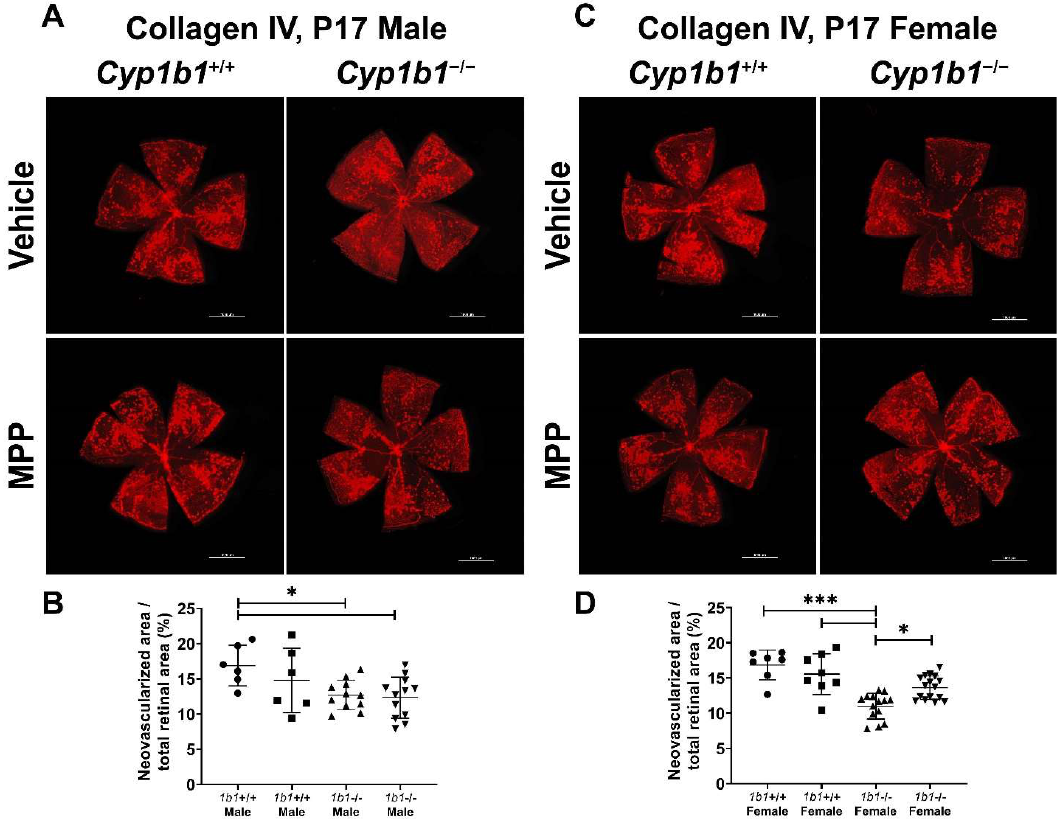
Figure 8. Restoration of retinal neovascularization in female Cyp1b1 − / − mice by ER α antagonist MPP during OIR. Retinas from P17 ( A ) Cyp1b1 +/+ mice and ( C ) Cyp1b1 − / − mice that were administrated with MPP (1 mg/kg; P12-P17) during OIR were wholemount stained with anti-collagen IV antibody and imaged by fluorescent microscopy. Scale bars = 1000 µm. Quantitative assessment of the neovascularization was performed using ImageJ and percentages of the neovascularized area relative to whole retina, shown in ( B , D ), respectively (* p < 0.05, *** p < 0.001; n ≥ 6; each point represents one retina).